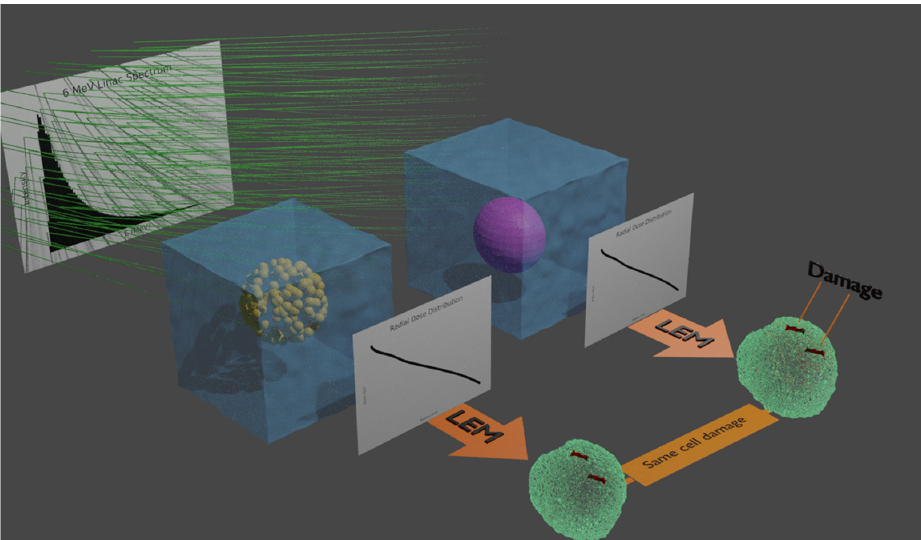
Figure 1. The histogram at the back shows the 6 MV Linac spectrum used to irradiate both a cluster of gold nanoparticles (GNPs) and the MixNP (homogeneous mix of gold and water) in order to calculate radial dose distributions (RDDs) in water (black curves). The cluster of GNPs is represented by many small gold spheres in the left-most water cube, whilst the gold-water mixture comprising the MixNP is represented by the magenta sphere in the right-most water cube. The RDDs were inserted into the local effect model (LEM) framework, represented as orange arrows, for the calculation of the biological effect.